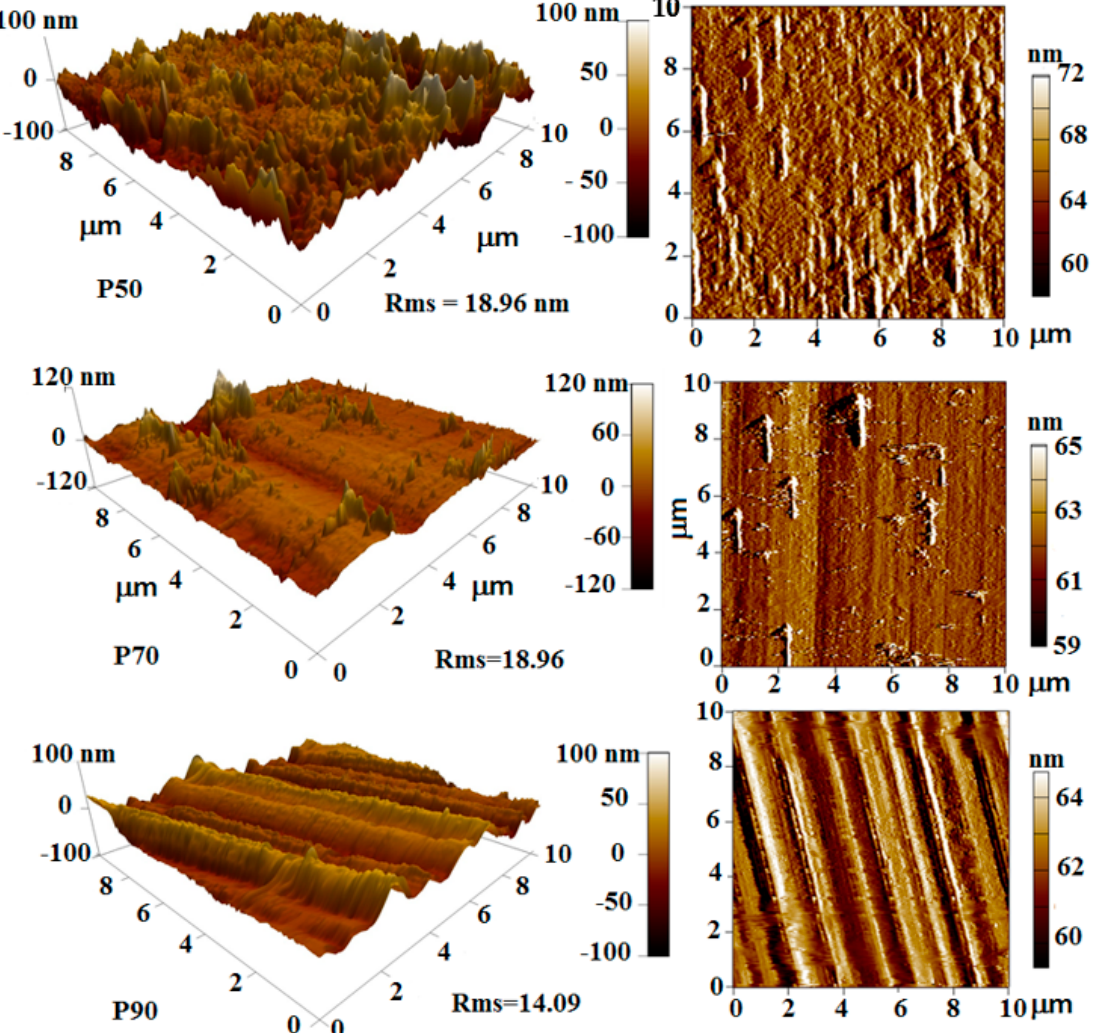
Figure 9. Typical AFM morphologies of selective laser melted samples.